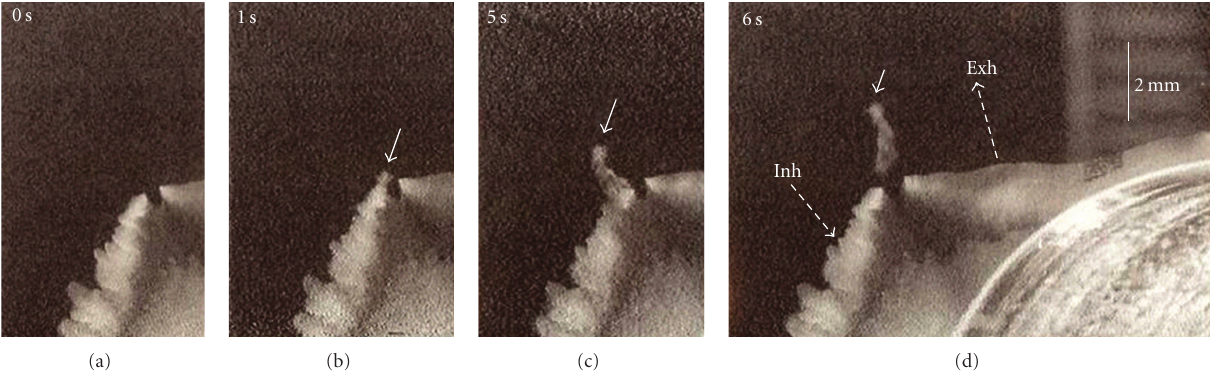
Figure 6: Mytilus edulis . Time series of videographic prints (0 to 6s) showing pseudofaeces (small arrow) being expelled from the mantle cavity close to the exhalant opening of a 34.3 mm shell length mussel exposed to 23,000 algal ( Rhodomonas salina ) cells mL − 1 . Inhalant (inh) and exhalant (exh) water indicated by dotted arrow.